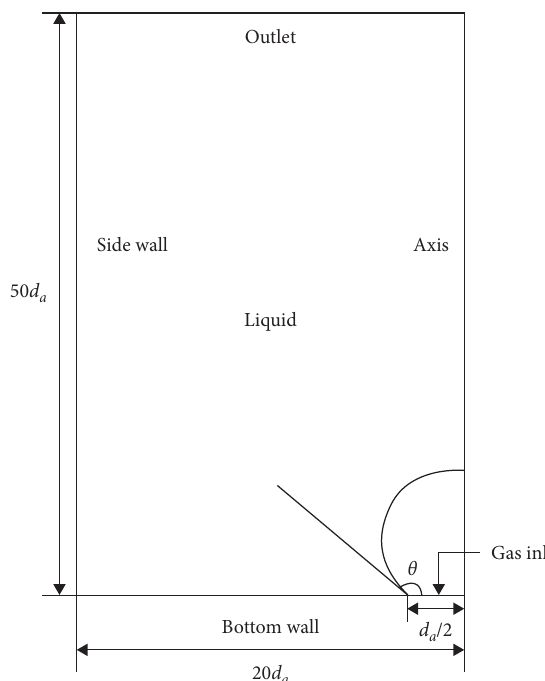
Figure 2: Computational domain for bubble formation from the